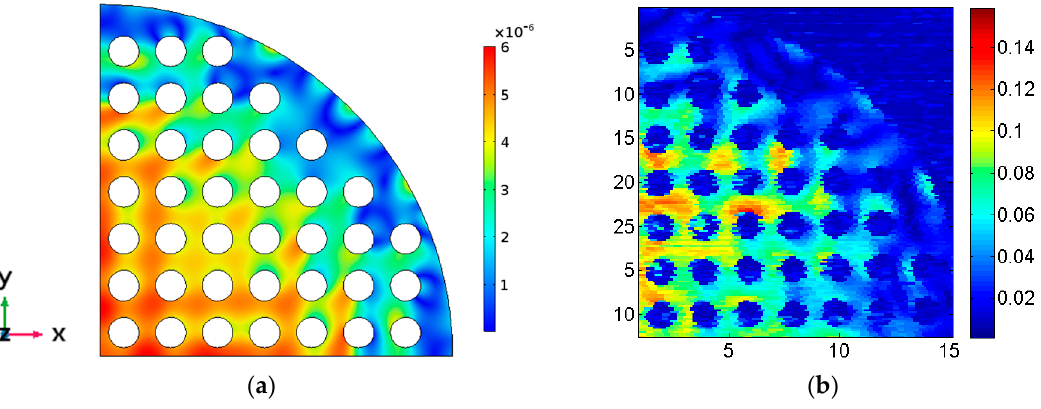
Figure 12. Model 6 out-of-plane mechanical displacement for the resonance frequency around 1 MHz. ( a ) FEM model, ( b ) experimental measurement in linear arbitrary units.